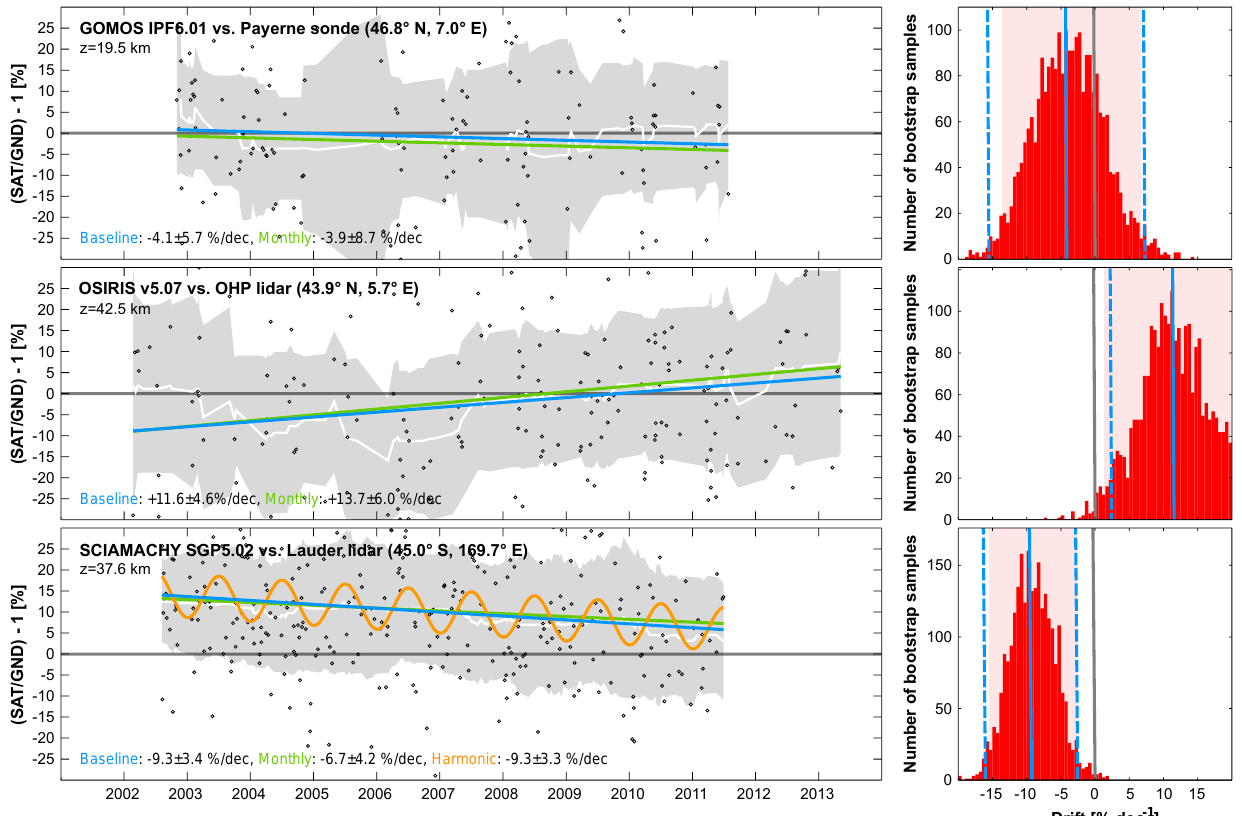
Figure 2. (Left) Time series of the ozone comparisons for GOMOS vs. Payerne ozonesonde at 19.5km (top), for OSIRIS vs. OHP lidar at 42.5km (centre), and for SCIAMACHY vs. Lauder lidar at 37.6km (bottom). A 1-year running median filter is applied to highlight long-term dependence (white line and 1 σ shaded area). The blue line depicts the baseline regression model, while the green and orange lines show cross-checks (see text). The estimated drift ˆ α and its 1 ˆ σ α uncertainty is mentioned at the bottom of each panel. (Right) Distribution of the drift obtained from 2500 bootstrapped samples of the time series on the left. The light red zone marks the 95% interpercentile of the drift distribution, which should be compared to the analytic expression ˆ α ± 2 ˆ σ α (vertical blue